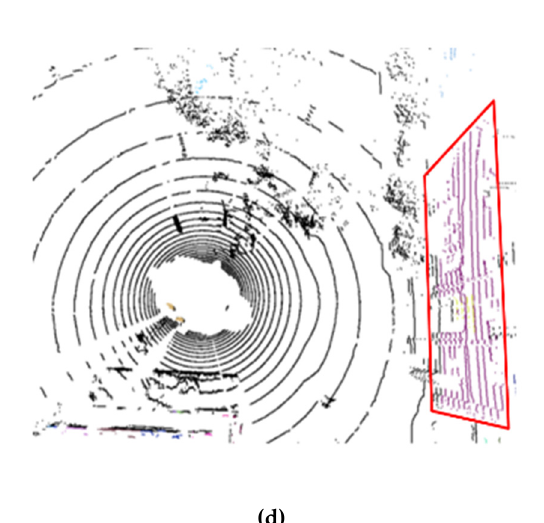
Figure 11. Plane detection results in different types of outdoor environments. ( a ) dataset 1; ( b ) dataset 2; ( c ) dataset 3; ( d ) dataset 4.